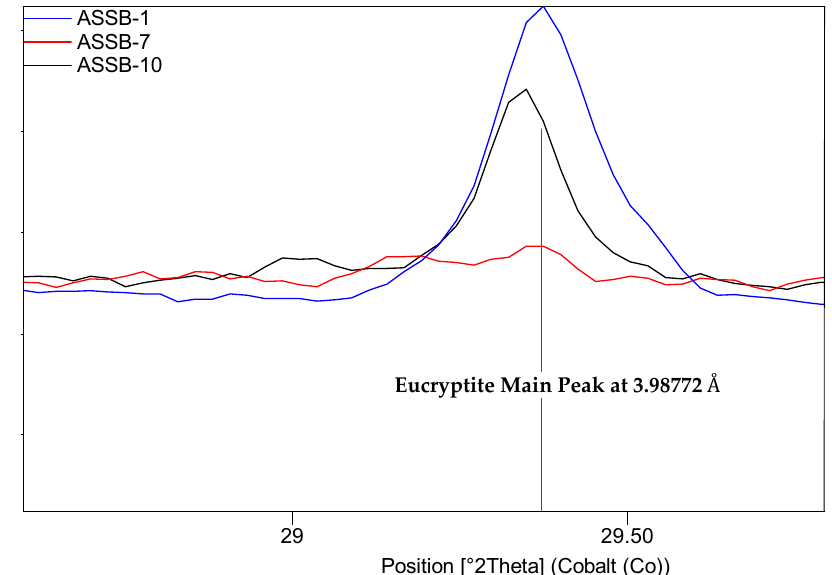
Figure 5. Section of PXRD measurements, with the main peak of Ec.